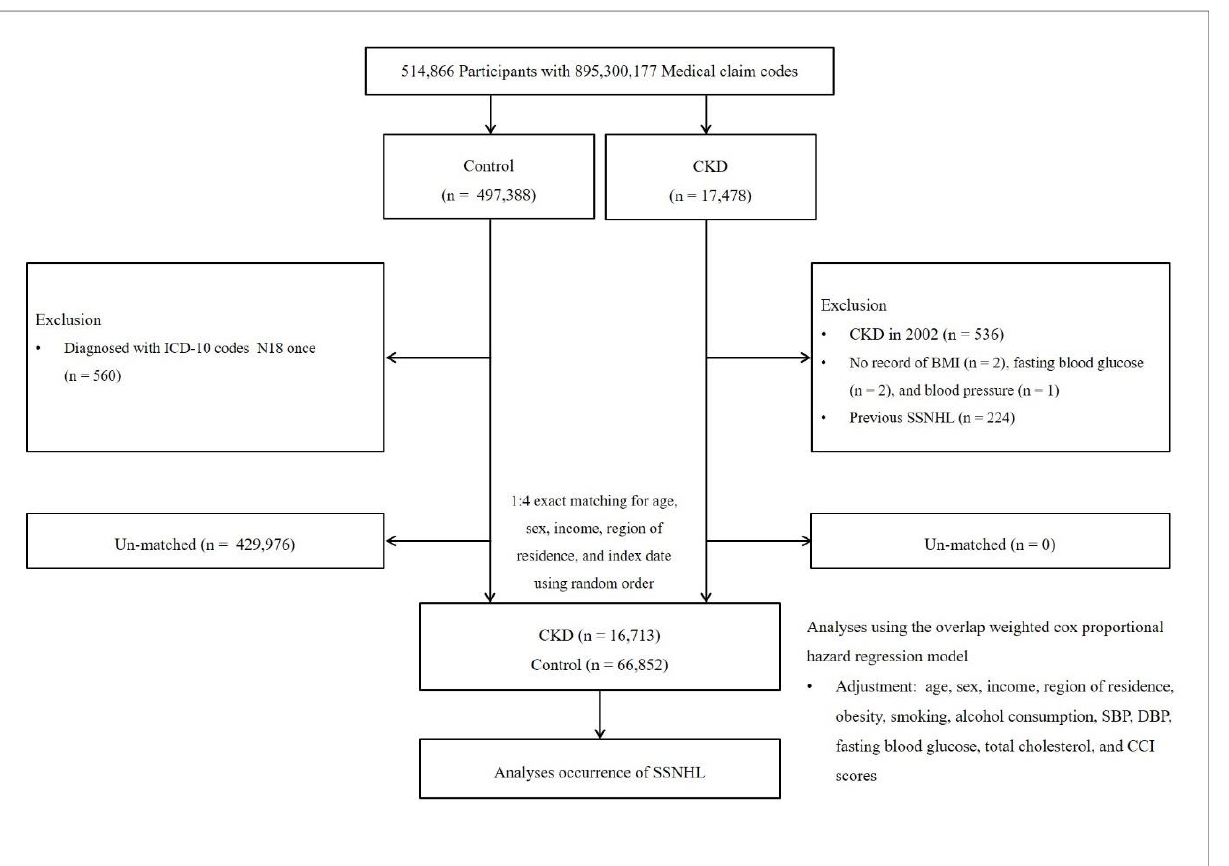
Figure 1. A schematic illustration of the participant selection process that was used in the present study. Of a total of 514,866 participants, 16,713 of CKD participants were matched with 66,852 of control participants for age, sex, income, and region of residence.